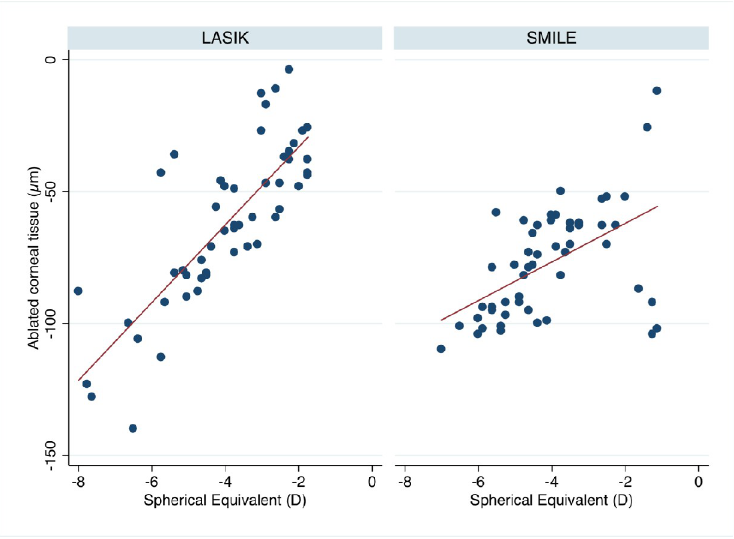
Fig 1. Correlation between the preoperative spherical equivalent and the alteration in corneal thickness (3-month postoperative minus preoperative values).